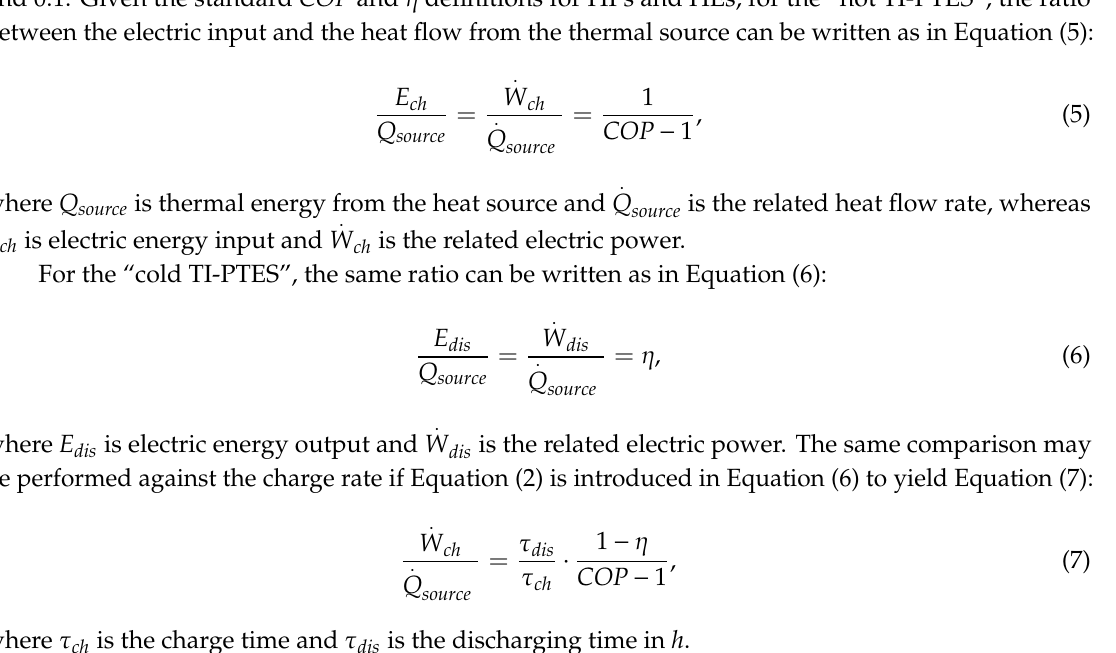
Figure 10. “Cold TI-PTES” performance parameters in terms of heat source temperature T source and TES temperature T tes . ( a ) VCHP COP ; ( b ) ORC η ; ( c ) TI-PTES ε rt .